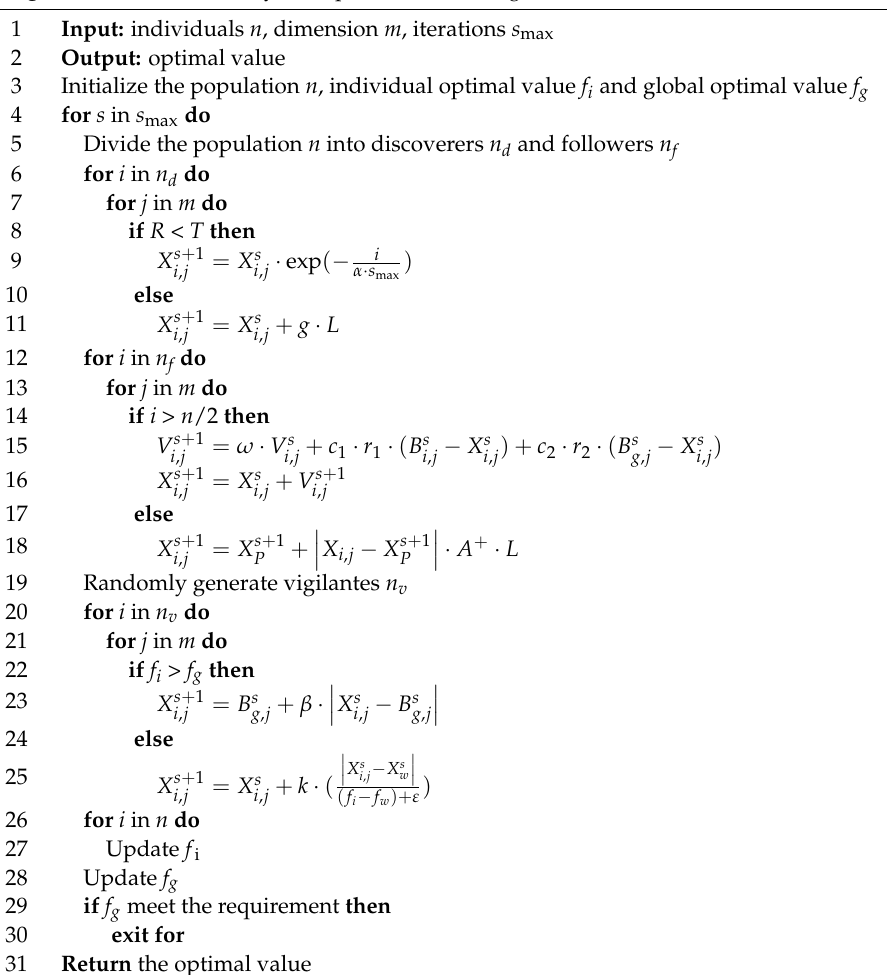
Algorithm 1. Procedure Hybrid Sparrow Search